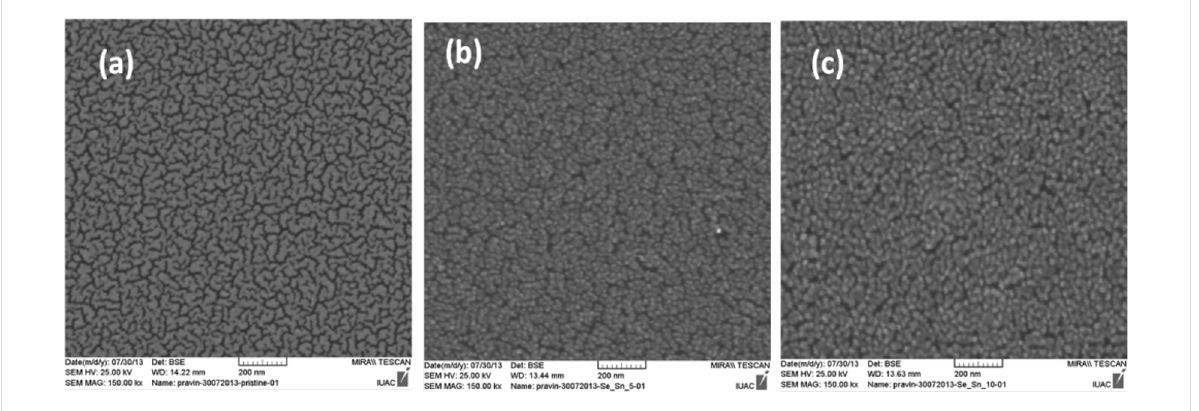
Figure 4: SEM images: a) pristine sample, b) 350 keV ion-irradiated film, and c) 600 keV ion-irradiated film.